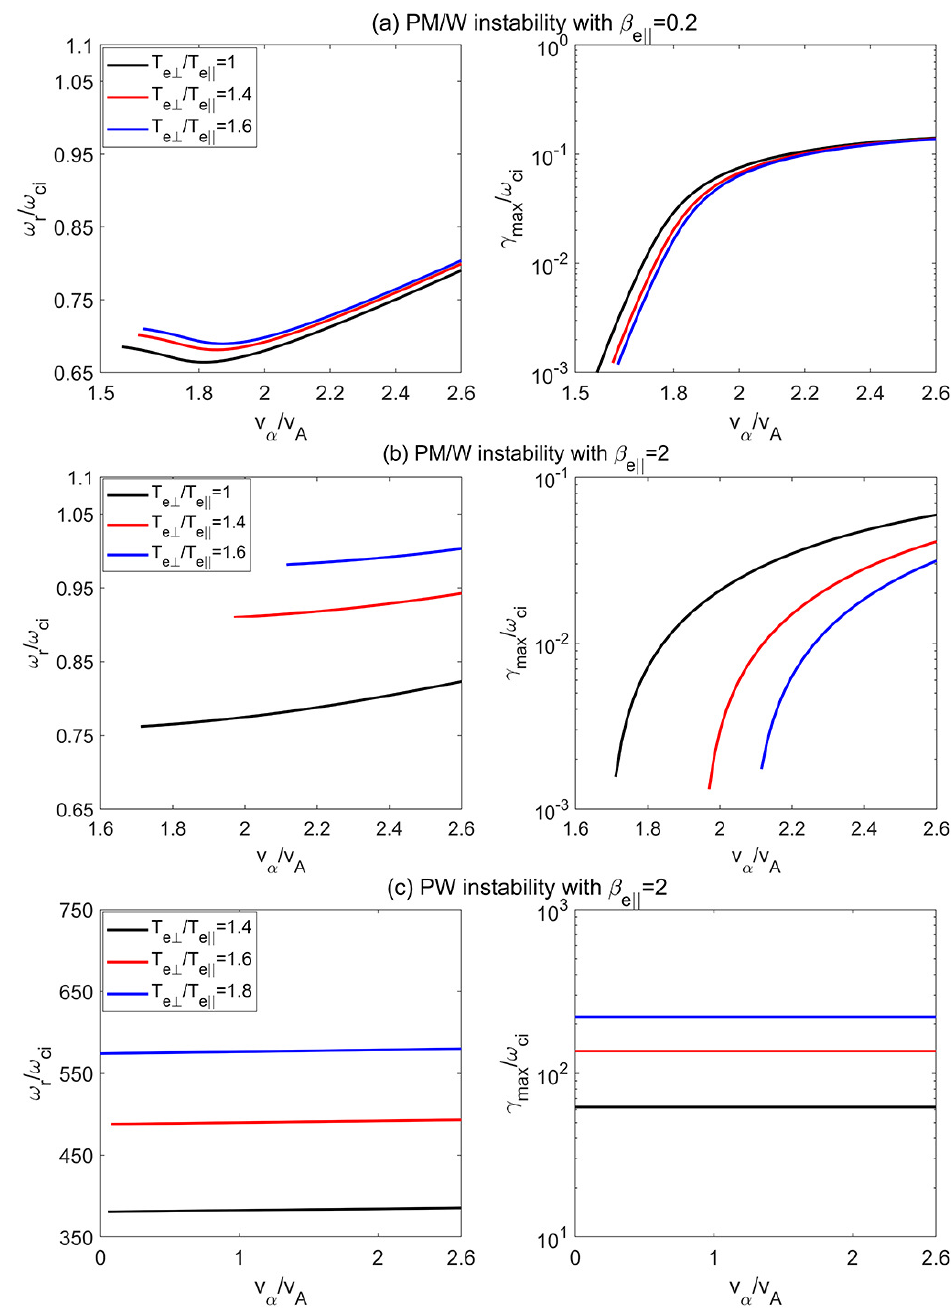
Figure 10. The real frequency ( ω r / ω ci ) and maximum growth rate ( γ max / ω ci ) versus the alpha beam drift velocity ( v α / v A ) for ( a ) the PM/W instability with β e (cid:107) = 0.2, ( b ) the PM/W instability with β e (cid:107) = 2, and ( c ) the PW instability with β e (cid:107) = 2. In ( a , b ), the black, red, and blue lines represent electron temperature anisotropies at T e ⊥ / T e (cid:107) = 1, 1.4, and 1.6, and in ( c ), these lines represent electron temperature anisotropies at T e ⊥ / T e (cid:107) = 1.4, 1.6, and 1.8,